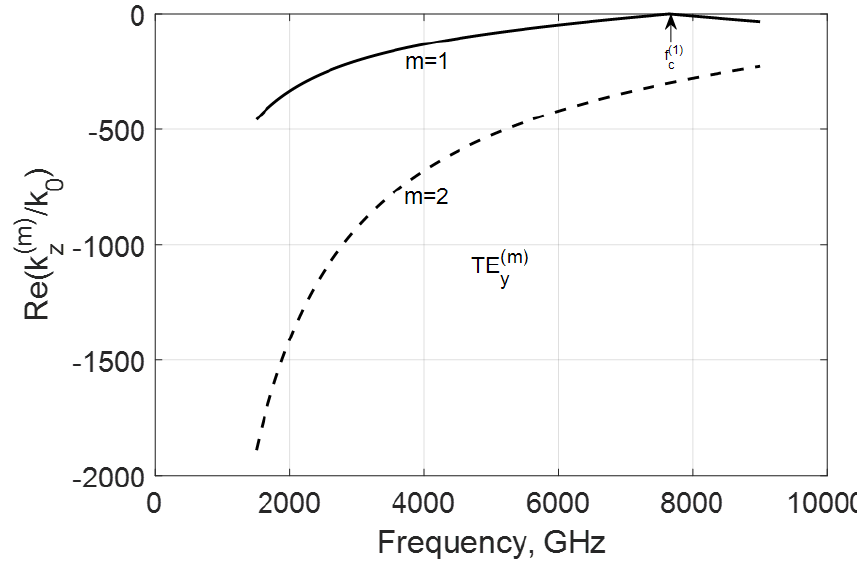
( m ) y z / k 0 of the first two TE